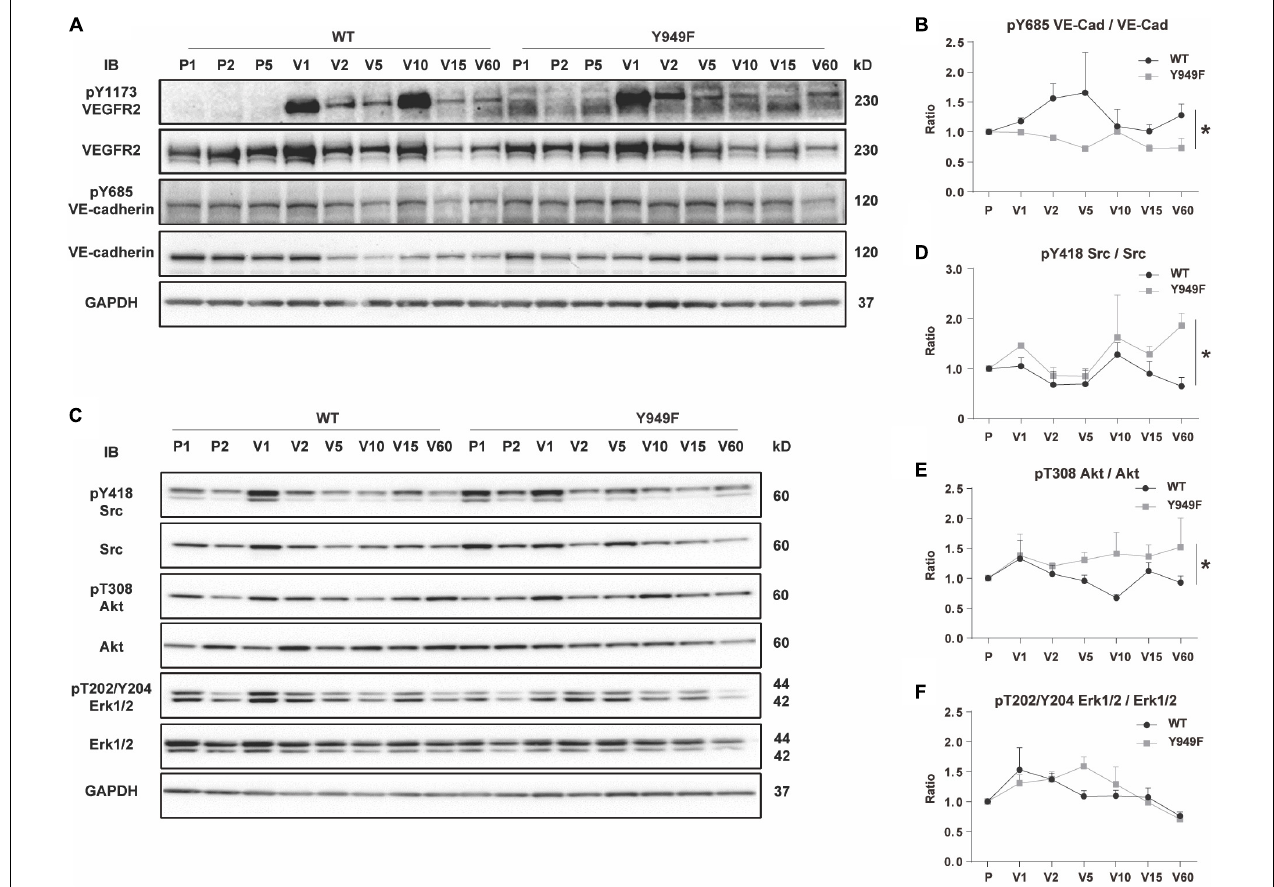
FIGURE 4 | VEGF-induced VE-cadherin pY685 accumulation in hearts. (A) Immunoblot for pY1173 VEGFR2 and total VEGFR2, and pY685 VE-cadherin and total VE-cadherin on heart lysates from WT and Vegfr2 Y 949 F / Y 949 F mice. Mice were injected with PBS or VEGFA in the tail-vein, followed by circulation for different time periods; PBS was injected and left to circulate for 1, 2 or 5 min (denoted P1, P2, P5). Alternatively VEGFA was injected and left to circulate for 1, 2, 5 min etc. (denoted V1, V2, V5 etc.). Heart lysates were immunoblotted for 3-phosphate dehydrogenase (GAPDH) as a loading control. (B) Quantification of pY685 VE-cadherin normalized to total VE-cadherin in samples shown in (A) . (C) Immunoblotting for pY418 c-Src and total c-Src, pT308 Akt and total Akt, pT202/Y204 Erk1/2 and total Erk1/2. (D–F) Quantification of phosphorylated protein bands normalized to the corresponding total protein. n = 3; i.e., three independent replicates of experiments as shown in panel (A) with one mouse/time point for each strain and nine mice in total/strain for each experiment. Wilcoxon test, * p <